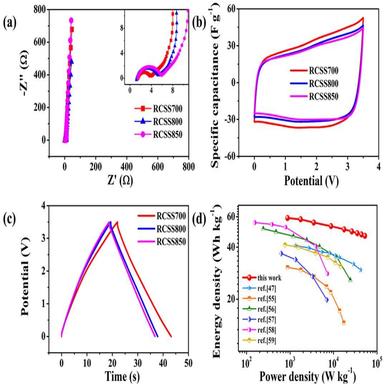
Electrochemical performance of the RCSS-based symmetrical supercapacitors in EMIMBF4 ionic liquid electrolyte. (a) Nyquist plots and the inset magnifies the high-frequency range. (b) CV curves for RCSSs at a scan rate of 100 mV s−1 . (c) GCD curves for RCSSs at a current density of 5 A g−1 . (d) Ragone plots of RCSS700 in comparison with other carbon materials in EMIMBF4 ionic liquid electrolytes.